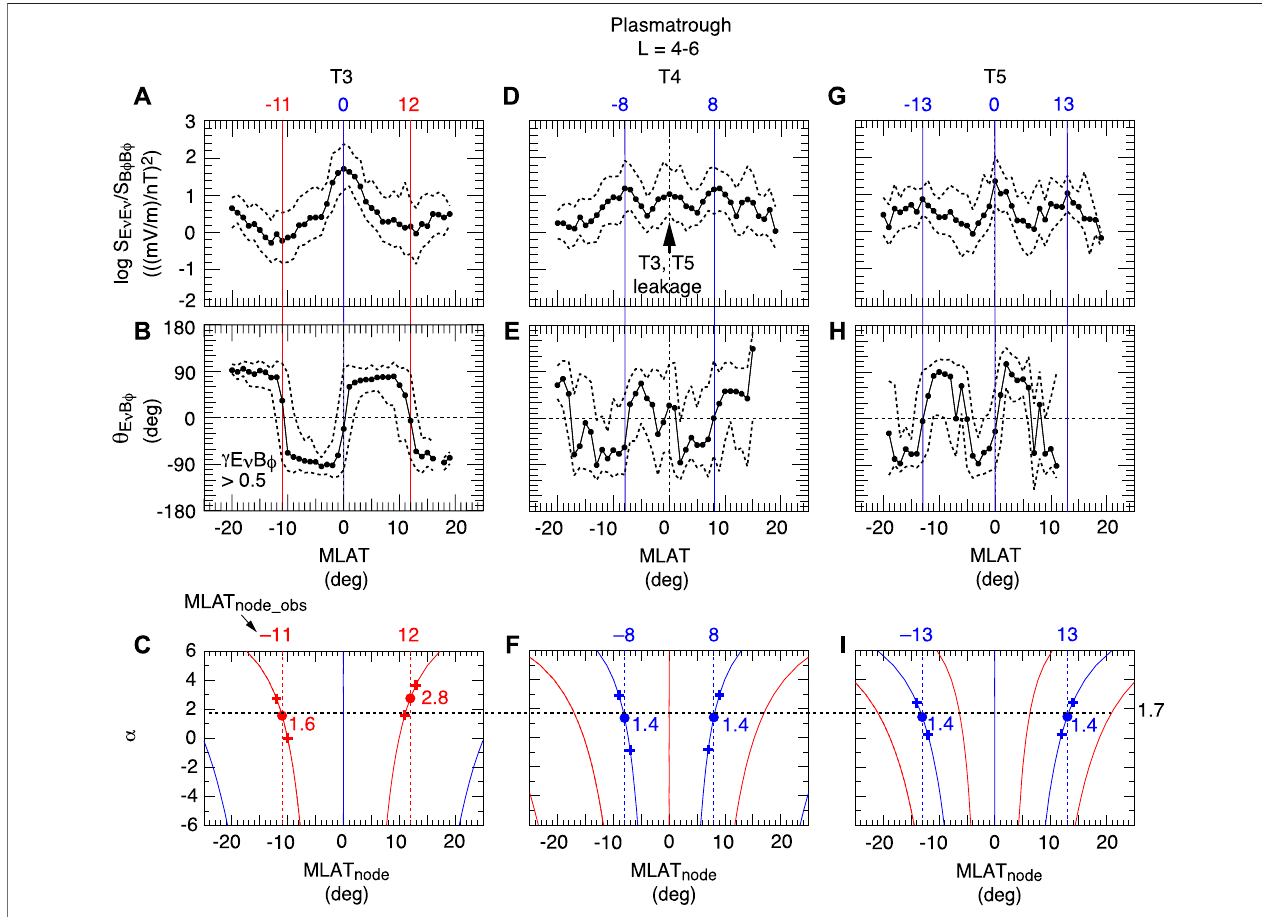
FIGURE 4 | Determination of the mass density model parameter α using the node latitudes of toroidal waves observed by RBSP (after Takahashi and Denton, 2021). (A) E ] to B ϕ power ratio in the band occupied by T3 waves. The black dots are the medians, and the dashed lines indicate the upper and lower quartiles. The colored vertical lines indicate the nodes of E ] (red) and B ϕ (blue). (B) E ] - B ϕ cross phase in the T3 wave band. (C) Mass density model parameter α corresponding to the node latitudes of T3 waves (D – F) Same as (A – C) but for T4 waves B Same as (A – C) but for T5 waves.